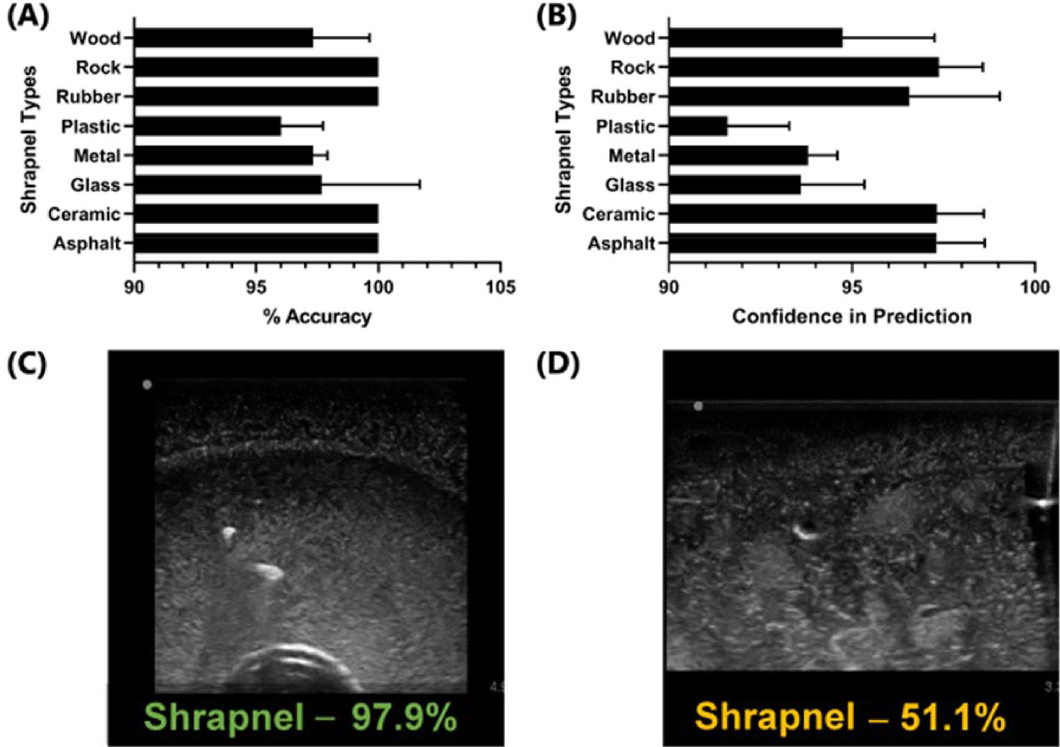
Figure 5. Model Performance for Different Shrapnel Types. ( A ) Accuracy and ( B ) prediction confidence for test phantom image sets for eight different shrapnel types: Asphalt (n = 33), Ceramic (n = 28), Glass (n = 14), Metal (n = 59), Plastic (n = 34), Rubber (n = 10), Rock (n = 29), Wood (n = 23). Results are shown as average values, and errors bars denote standard deviation. Representative images for glass shrapnel type for ( C ) high prediction confidence and ( D ) low prediction confidence. Additional representative images for all other shrapnel types are provided in Supplementary Fig.